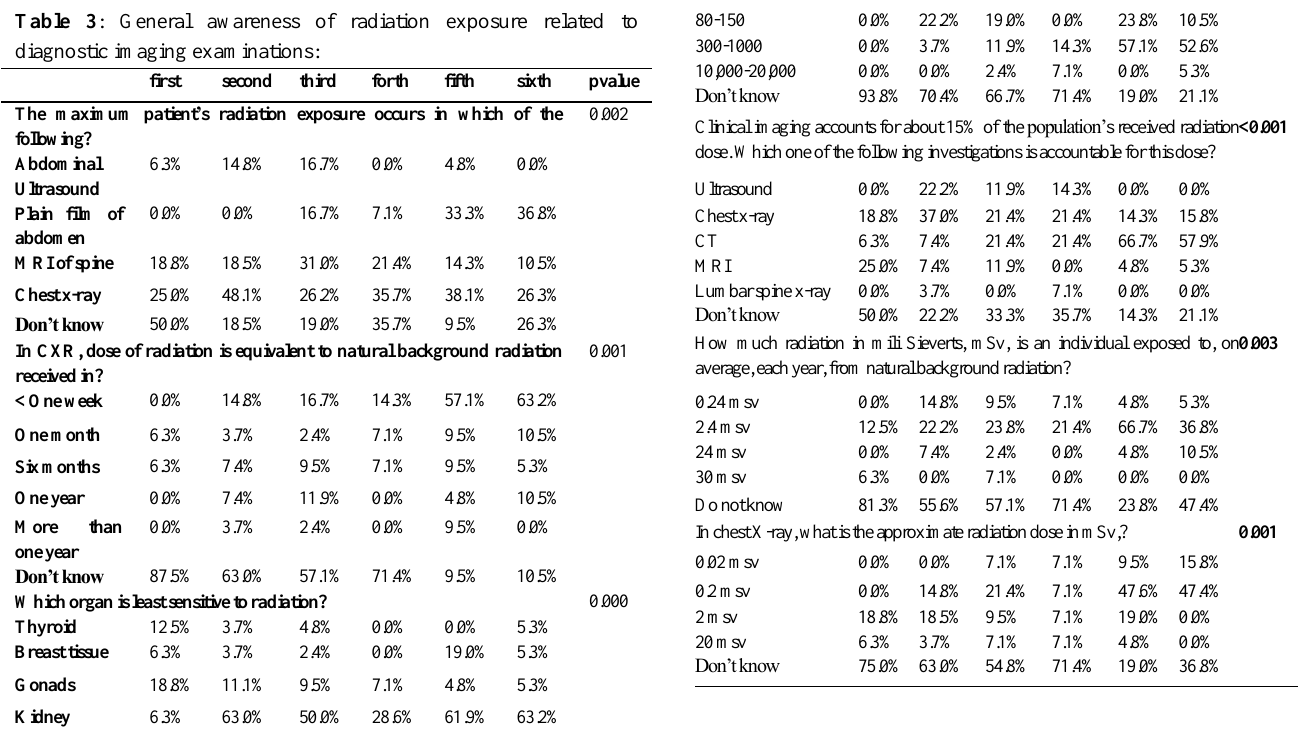
P value sixth fifth fourth third second first <0.001 The radiation dose in abdominal CT is about equal to how many CXR?